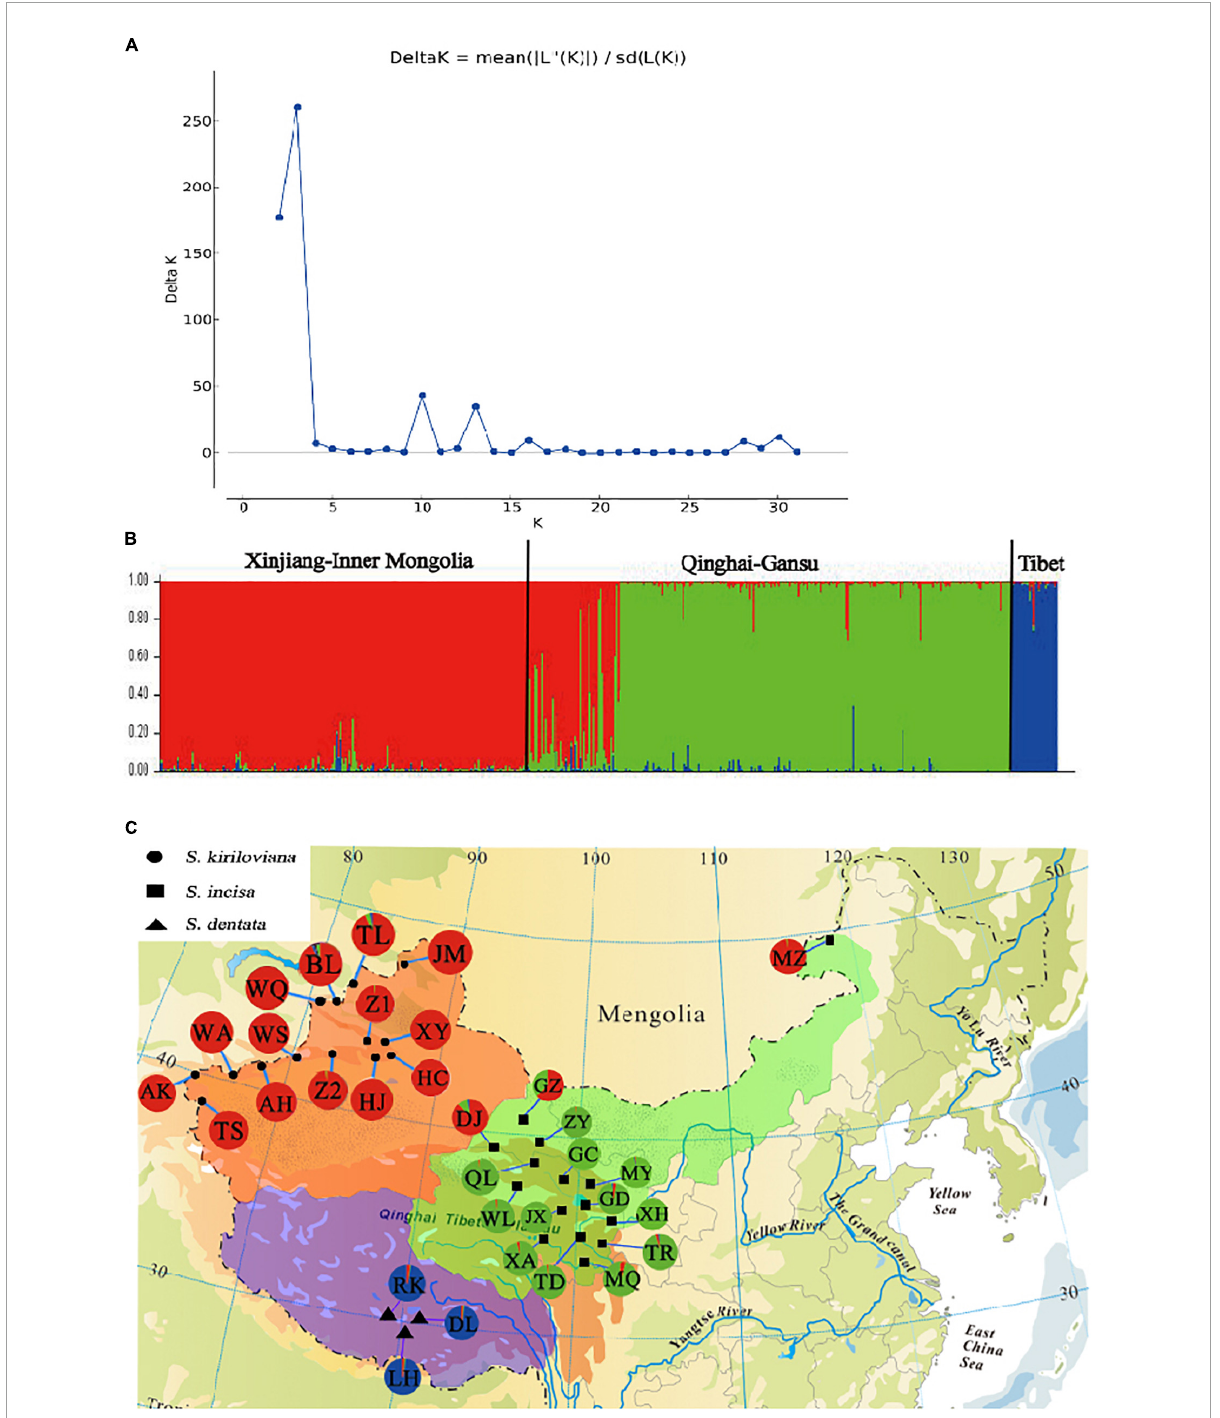
FIGURE4 Bayesian clustering results of the STRUCTURE analysis for nSSR data of 530 individuals (32 populations) of Scrophularia incisa complex from Northwest China. Number of clusters ( K ) was varied from 1 to 32 in 10 independent runs. (A) The dot plot represents changes of the mean posterior probability [log e P( D )] ( ± SD) values of each K calculated according to Pritchard et al. (2000), whereas the superimposed line diagram indicates the corresponding (cid:49) K statistics calculated according to Evanno et al. (2005). (B) Histogram of the STRUCTURE analysis for the model with K = 3 (showing the highest (cid:49) K ). The smallest vertical bar represents one individual. The assignment proportion of each individual into one of three population clusters (or “gene pools”) is shown along the y -axis. (C) Geographic origin of the 32 S. incisa complex populations and their color-coded grouping according to the STRUCTURE analysis. Population codes are identified in Supplementary Table 1